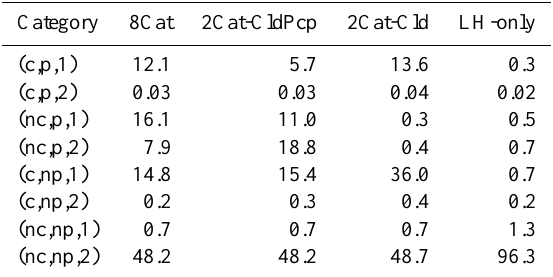
Table 4. RICO: percentage of sample points allocated to each cat- egory by each sampling method at the importance sampling level, time-averaged over the entire simulation. The more sample points placed in a particular category, the better the estimate of processes active in that category.